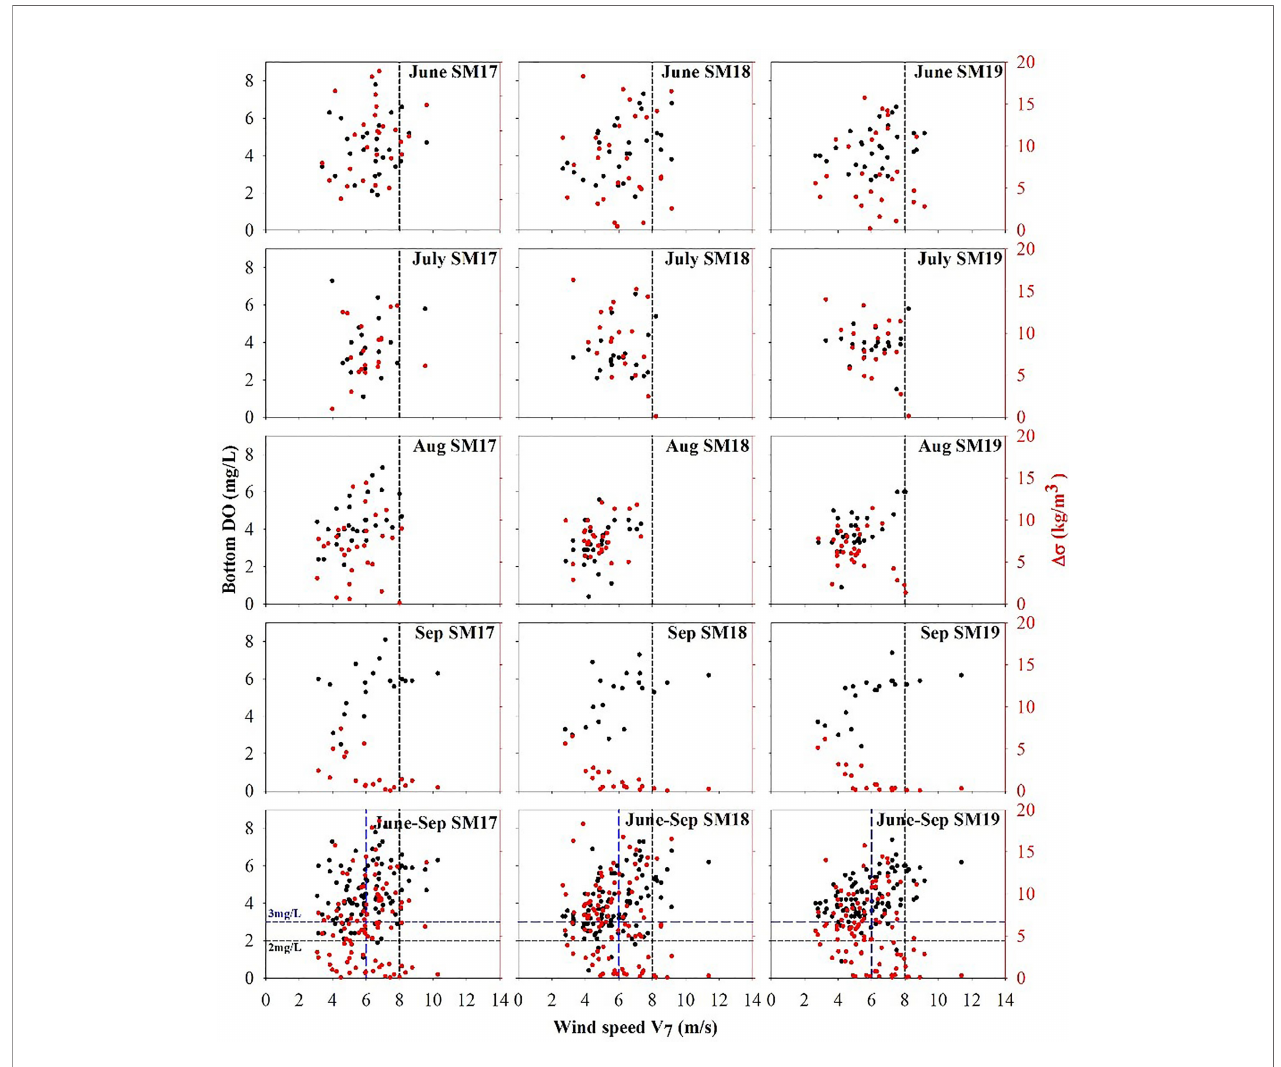
FIGURE 6 | The relationship between bottom DO, △ s and wind speed V7 in summer during 1990-2018 at SM17, SM18 and SM19.